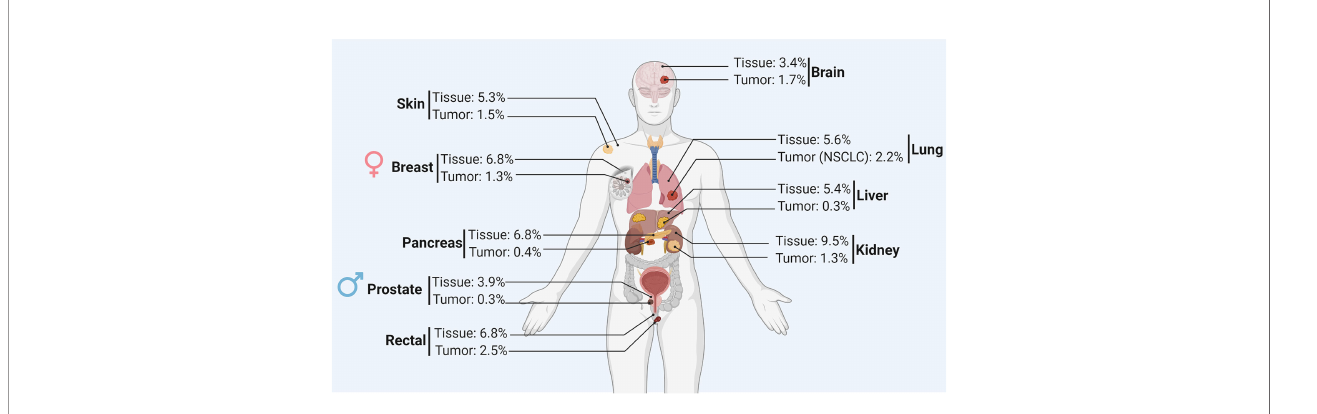
FIGURE 2 | Summary of the oxygen level (reported as a percentage) in the healthy tissue and corresponding tumor of